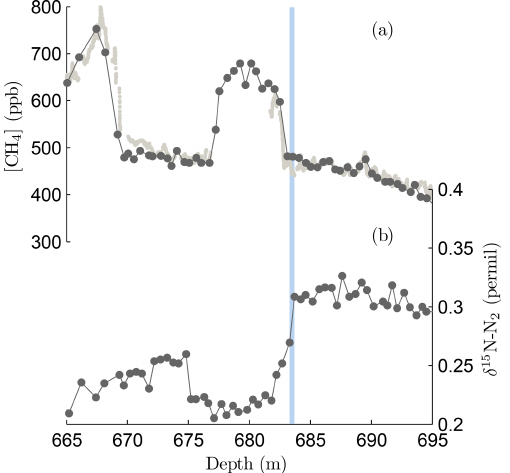
Figure 9. Comparison of (a) methane and (b) δ 15 N-N 2 from the RICE ice core plotted on depth. Vertical blue bar highlights the on- set of a large decrease in δ 15 N-N 2